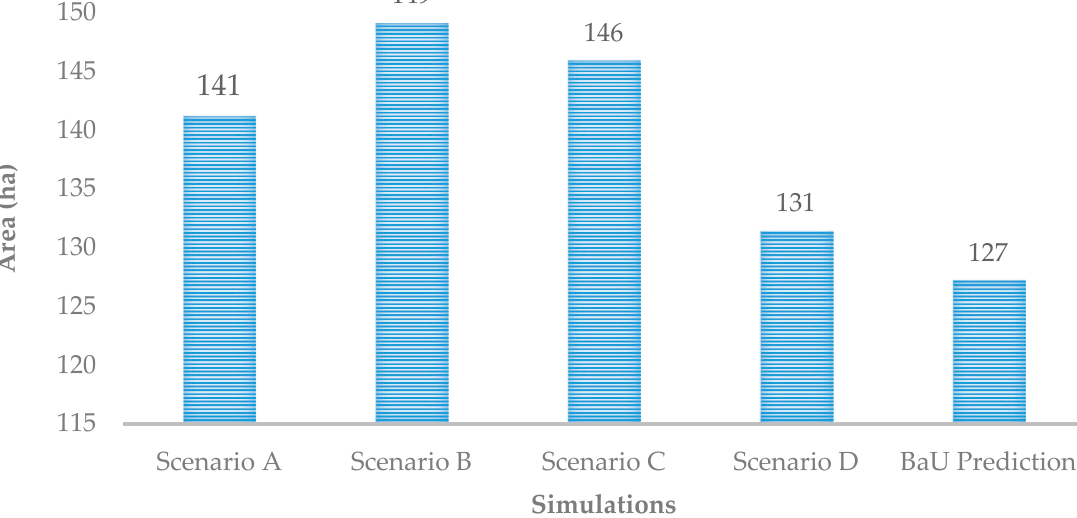
Figure 5. Urban growth scenarios for Monastir until 2030, for areas with a 0.5 probability of conversion to urban. BaU: business-as-usual.